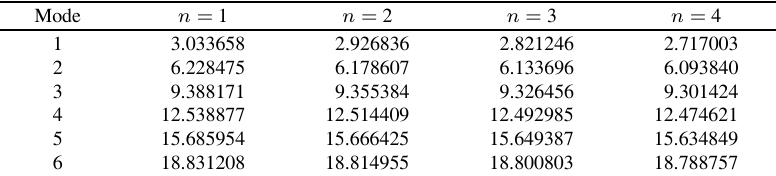
Table 4 Non-dimensionalnaturalfrequenciesofclamped-clampedrodswith A ( x ) = A 0 sin n ( ax + b